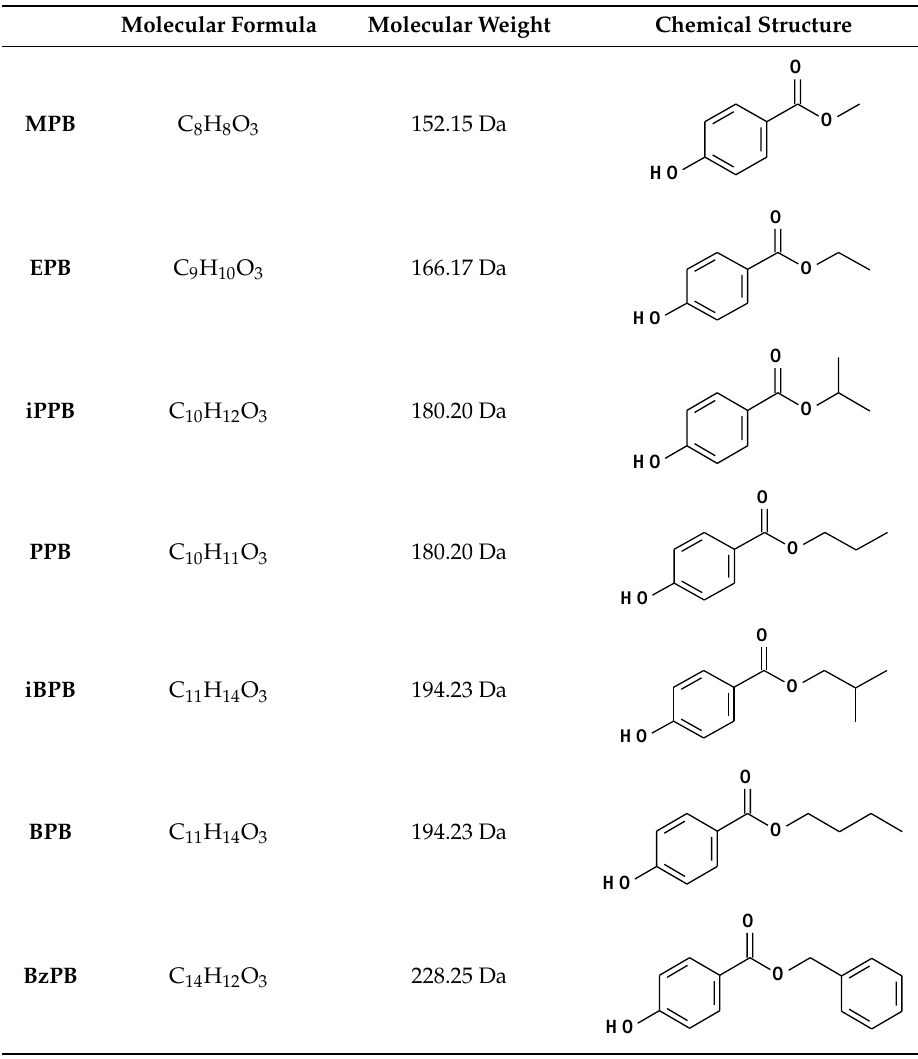
Molecules 2019 , 24 , x